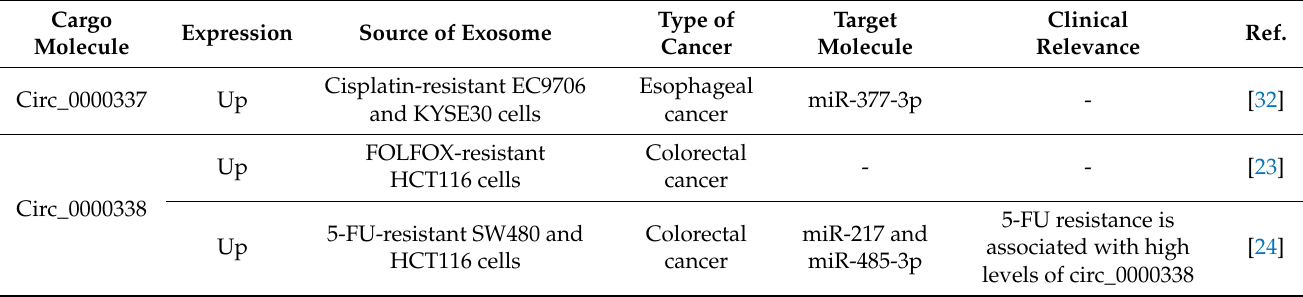
Table 1. Exosomal circRNAs in gastrointestinal cancers (in alphanumerical order).